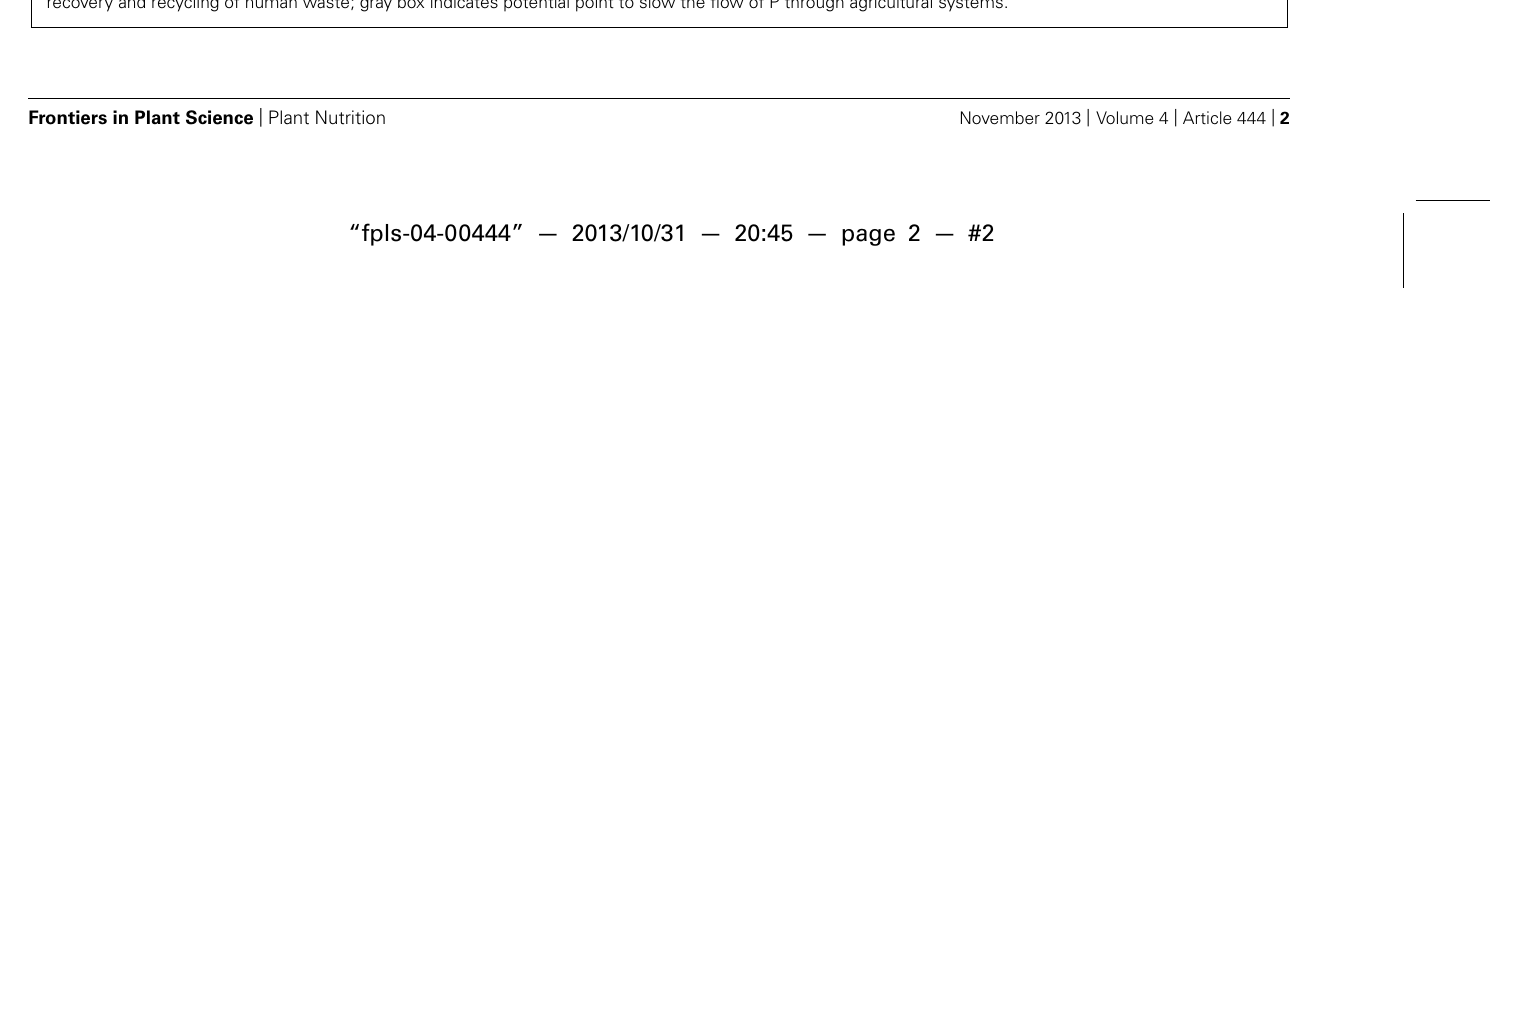
Frontiers in Plant Science | Plant